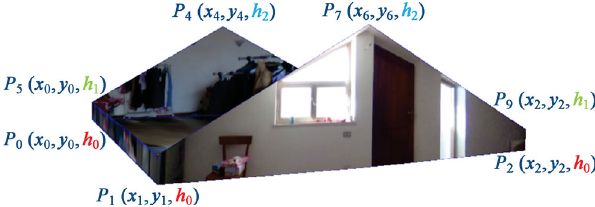
Fig. 8 3D room generation. We exploit the 3D information contained in facets closest to the recovered 2D shape to generate the 3D points. In the sloping ceiling case illustrated ( D3-Loft ) 3 height levels h 0 , h 1 , h 2 have been recovered and associated with 3D vertices. Note that the windows and doors are actually sloping in this particular